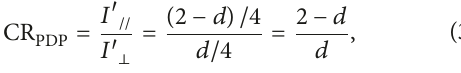
Figure 2: The vertical view images of subpixel color filter in dark